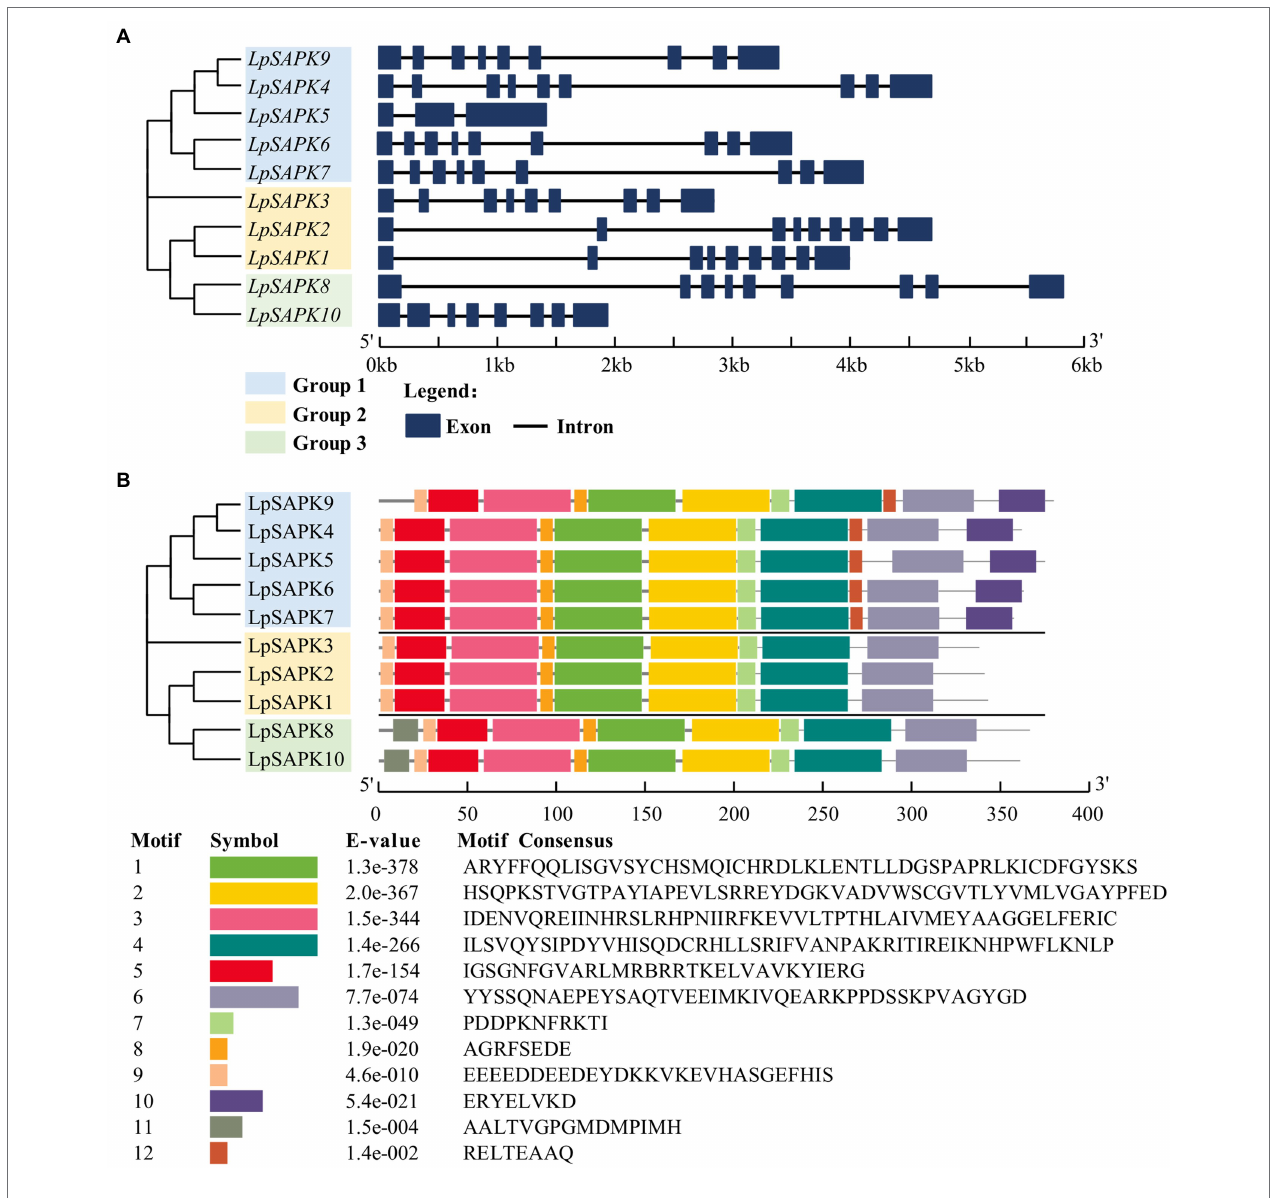
FIGURE 3 | Phylogenetic relationships, genic structures, and conserved motif composition of LpSAPKs . (A) Phylogenetic relationships and exon–intron organizations of the LpSAPKs . Exons and introns are shown by filled boxes and single lines, respectively. (B) Motif analysis of LpSAPKs . Each colored box represents a motif in the protein, with the motif name indicated at the bottom of the